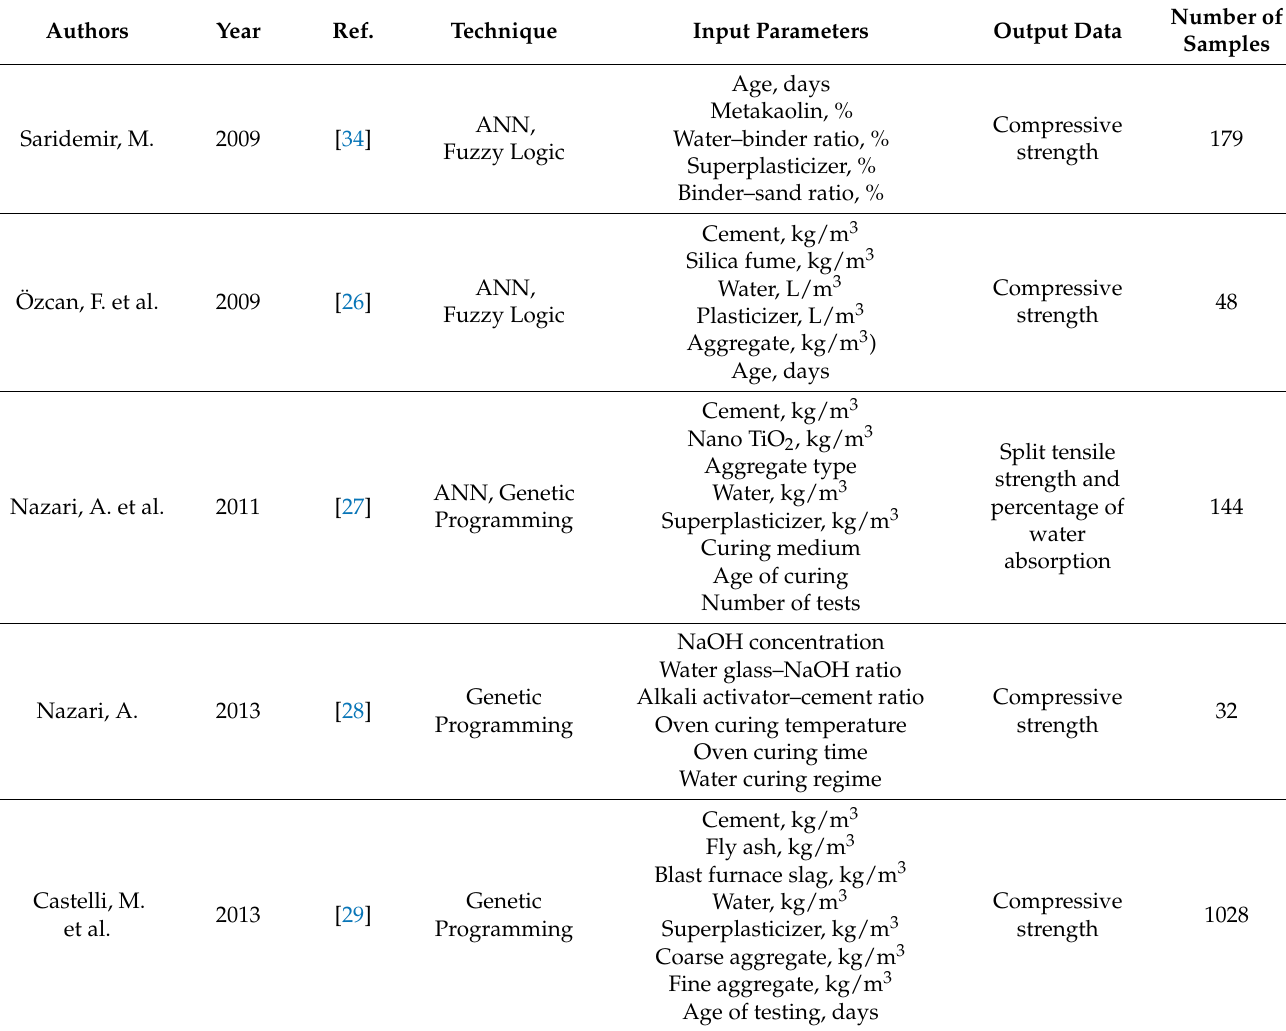
Table 1. Summary of AI approaches for estimating concrete